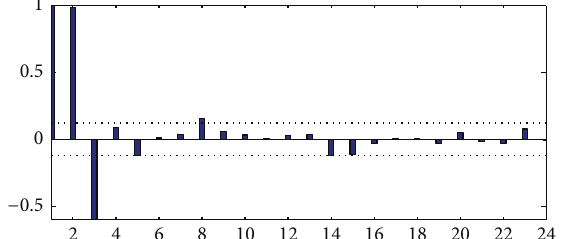
Figure 5: Sample PACF function of the relative (sqrt) incidence of American Tegumentary Leishmaniasis cases in Department of Or´an, Salta, Argentina, period 1985–2007, smoothed with 24 months.